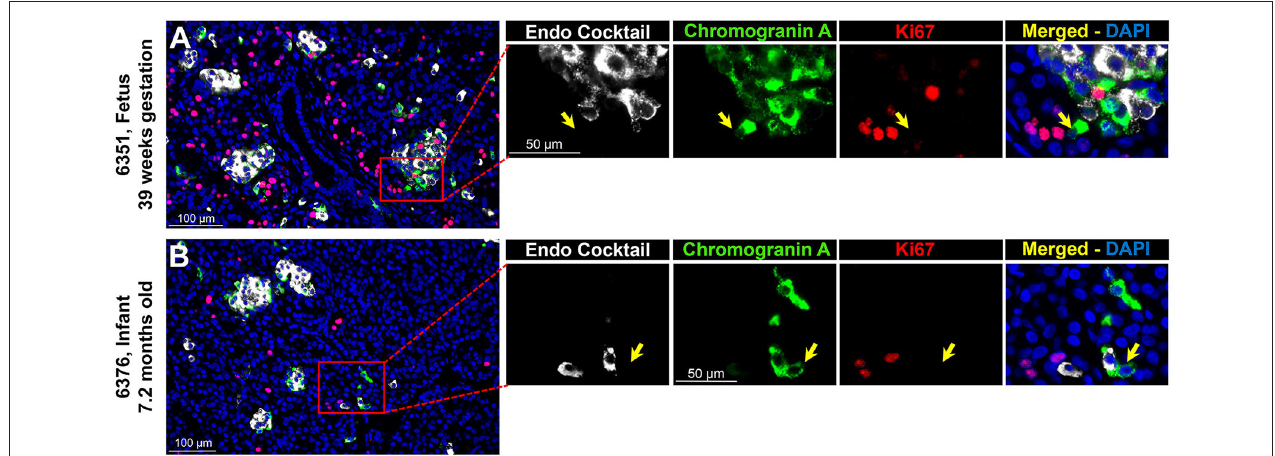
FIGURE 2 | ChromograninA positive hormone-negative (CPHN) cells do not replicate during fetal and infant life. Representative pancreatic sections from fetal (A) and infant (B) donors immunostained for Endocrine cocktail (insulin, glucagon, somatostatin, pancreatic polypeptide, and ghrelin) (white), chromograninA (green), Ki67 (red), and DAPI (blue). Yellow arrows indicate CPHN cells. CPHN cells were rarely positive for Ki67 staining in both fetal and infant groups; no detectable difference was found in the frequency of replicative CPHN cells between fetal and infant pancreatic sections. Scale bars: 100 µ m for low power and 50 µ m for high magnification